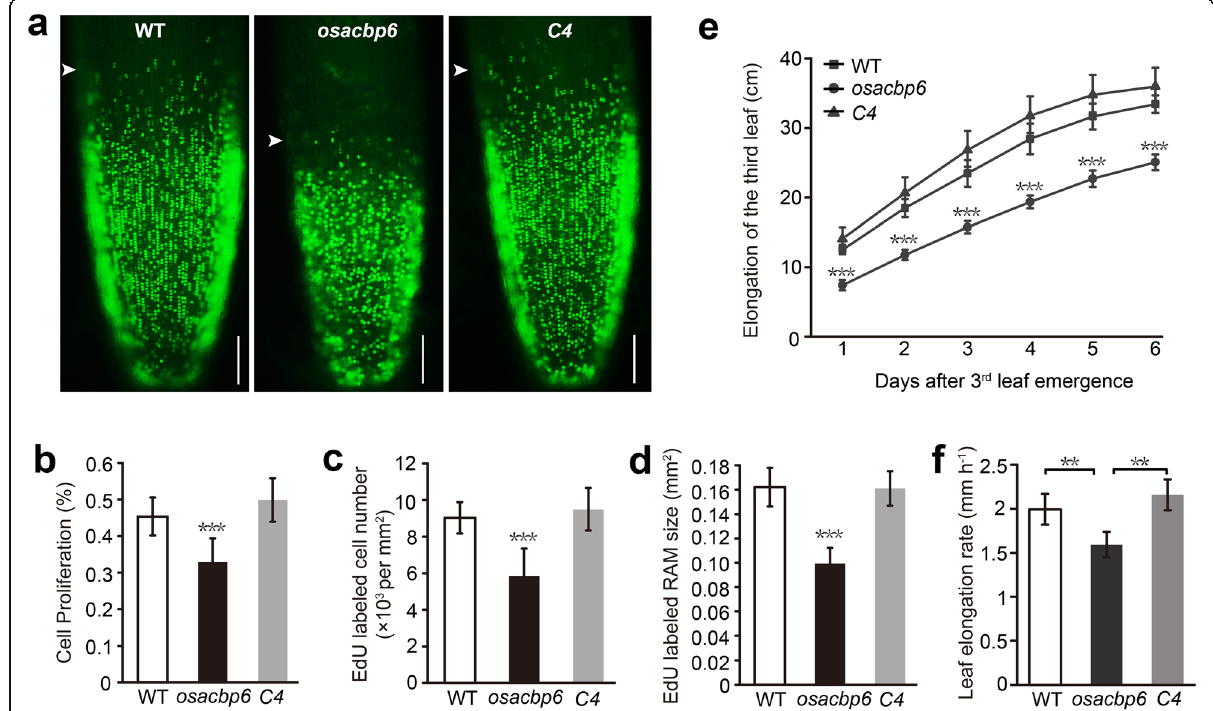
Fig. 3 Reduced root meristem activity and leaf elongation in the rice osacbp6 mutant. a Representative cell proliferation in the root tip cells of 5- day-old wild-type (WT), osacbp6 and complemented line osacbp6 - C4 ( C4 ) seedlings visualized by 5-ethynyl-2 ′ -deoxyuridine (EdU) staining. Bars, 100 μ m. Arrowheads indicate the border of EdU staining. b - d Relative quantification of the proliferating cells labeled with EdU, including the percentage of cell proliferation calculated as the ratio of EdU/DAPI ( b ), average proliferating cell number ( c ), and EdU-labeled root apical meristem size ( d ). Values are means ± SD ( n = 10). e and f Measurement of the length of the third leaf ( e ) and leaf elongation rate ( f ). Values are means ± SD ( n = 5). Asterisks indicate significant differences as evaluated by Student ’ s t -tests: ** P < 0.01, *** P < 0.001. DAPI, 4 ′ ,6-Diamidino-2- Phenylindole; WT, Oryza sativa var. japonica cv.